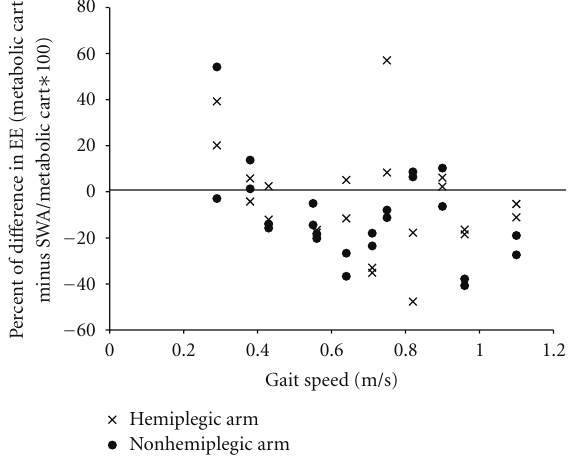
Figure 3: Scatterplot between gait speed and percent di ff erence of energy expenditure (EE) for the SenseWear Armband (SWA) and metabolic cart. Percent di ff erences less than zero indicate overestimation by the SWA. Each participant has four data points (one for each arm for each 6-minute walk test), viewed in a vertical line from the gait speed value. Note: there are only two data points for the participant for whom the SWA malfunctioned on the hemiplegic arm.